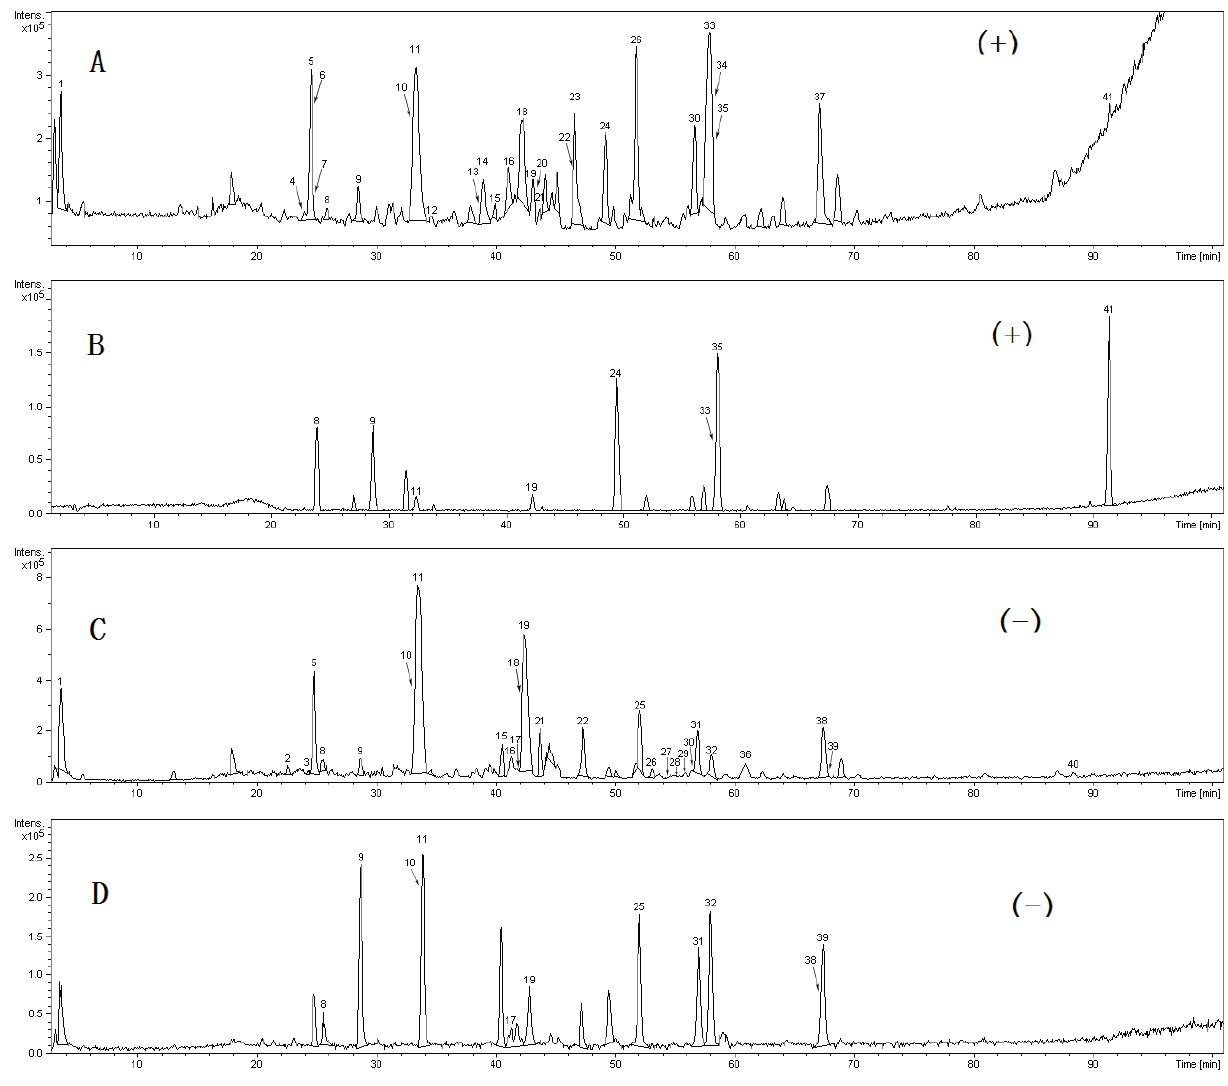
Figure 1. HPLC-Q-TOF-MS/MS total ion chromatogram ( A ) TIC of STP drug in positive mode ( B ) TIC of reference substances in positive mode ( C ) TIC of STP drug in negative mode ( D ) TIC of reference substances in negative mode. Standards are as follows: salvianolic acid B, arenobufagin, TDCA, TCA, Rg2, Rh1, bufalin, CA, UDCA, HDCA, resibufogenin, cinobufagin, CDCA, tanshinone IIA, and